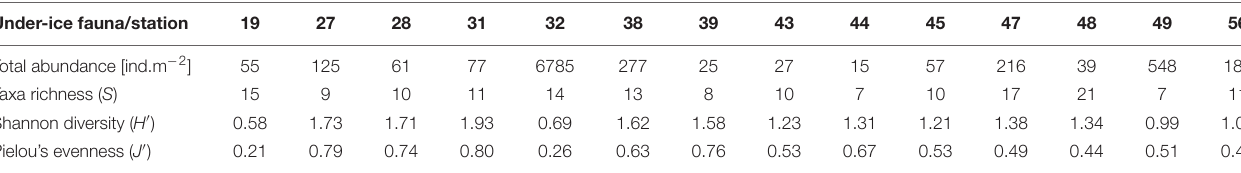
TABLE 5 | List of total abundances and biodiversity indices for under-ice fauna per station. Under-ice